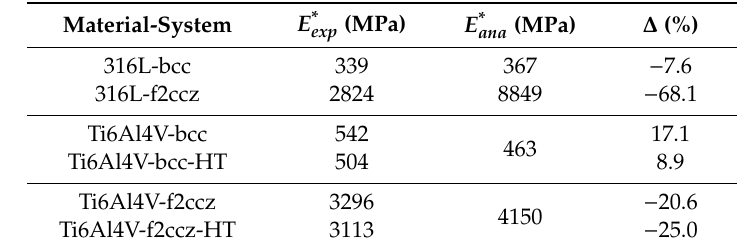
Table 7. Experimental results in comparison to the analytical values providing for calculation of relative deviation.